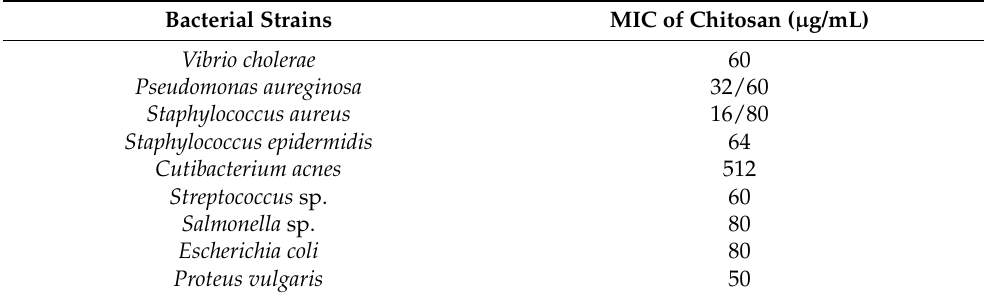
Table 1. Minimal inhibitory concentration of chitosan for selected bacterial strains (including acne- related bacteria) [109,110]